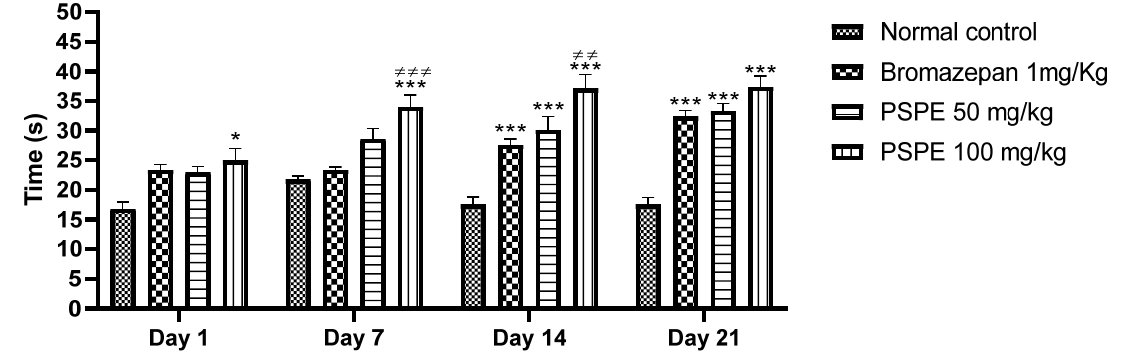
Figure 4. Variation in time spent at the center of the open field during the four-week treatment in control and extract-treated mice (* p ≤ 0.05, *** p ≤ 0.001 in comparison to negative controls, ≠≠ p ≤ 0.01 and ≠≠≠ p ≤ 0.001 in comparison to positive controls). PSPE: Polyphenolic fraction of P. sativum.